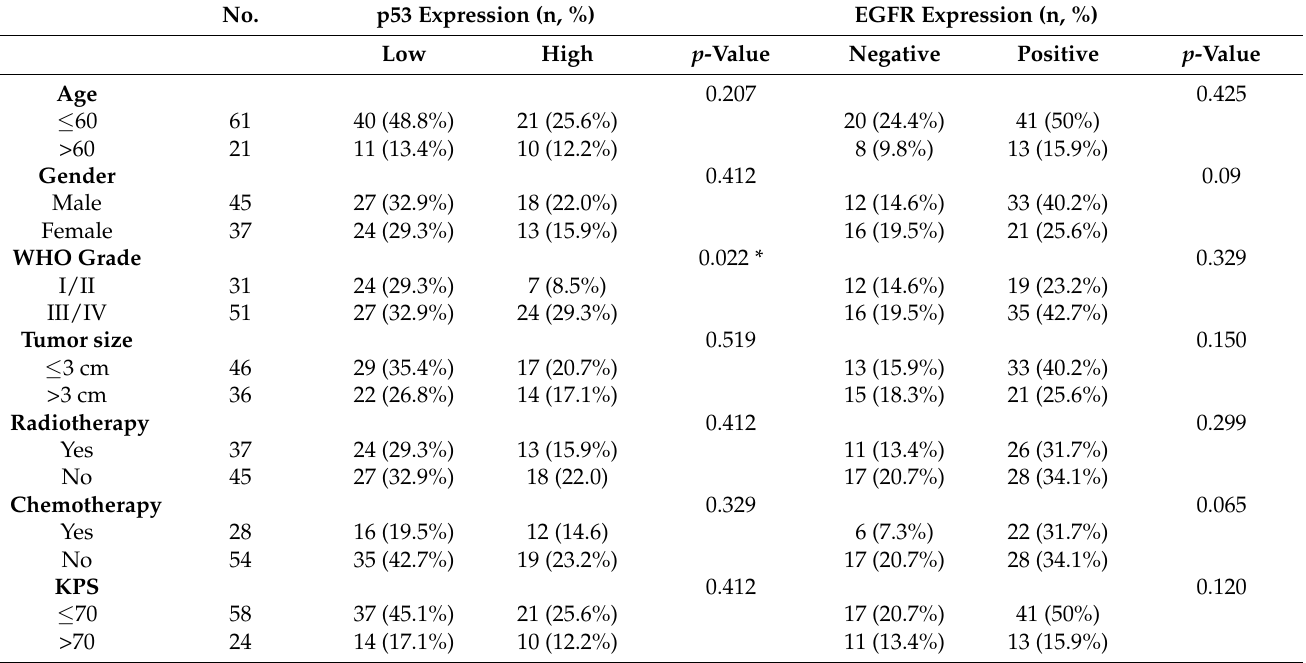
Figure 2. Immunohistochemical staining for EGFR in astrocytomas. ( A ) Astrocytoma with strong EGFR expression in a patient with glioblastoma. ( B ) Astrocytoma with weak EGFR expression in a patient with grade III tumor (100×). Table 1. Correlation of p53/EGFR expression with clinicopathologic parameters in astrocytomas.